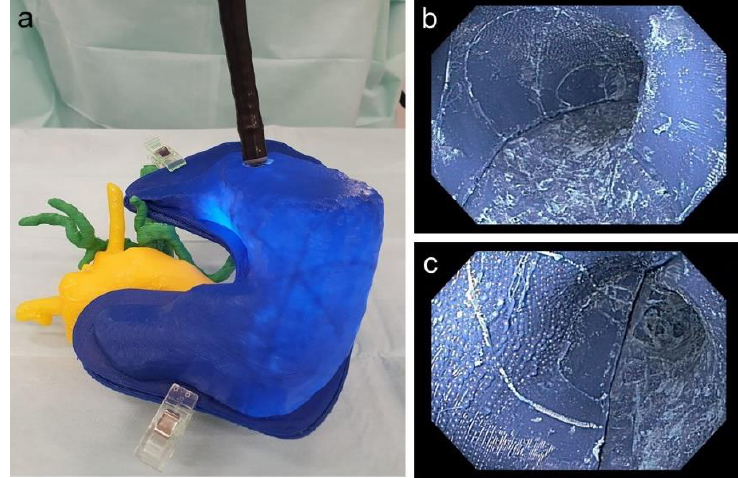
Figure 10. ( a ) Endoscope inside the stomach with adjacent printed pancreas as well as vessels; ( b ) endoscopic view of the corpus of the printed stomach; ( c ) endoscopic view of the antrum of the printed stomach.